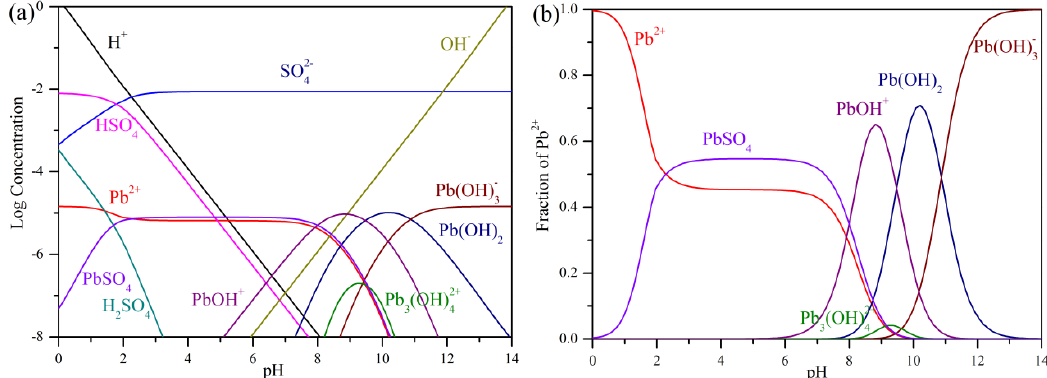
Figure 5. Calculated species distributions of 8.67 mM SO 42− reacting with 0.0145 mM Pb 2+ at different pH: ( a ) with log concentration vs. pH; ( b ) with fraction of lead vs. pH.